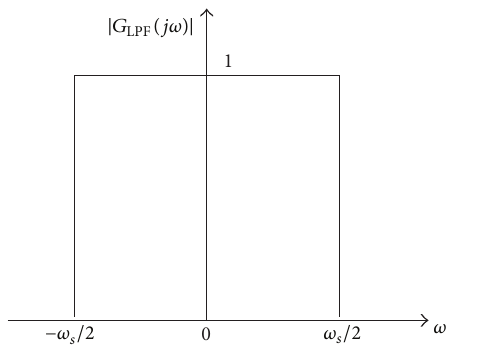
Figure 3: Frequency response of an ideal filter or an ideal holder.